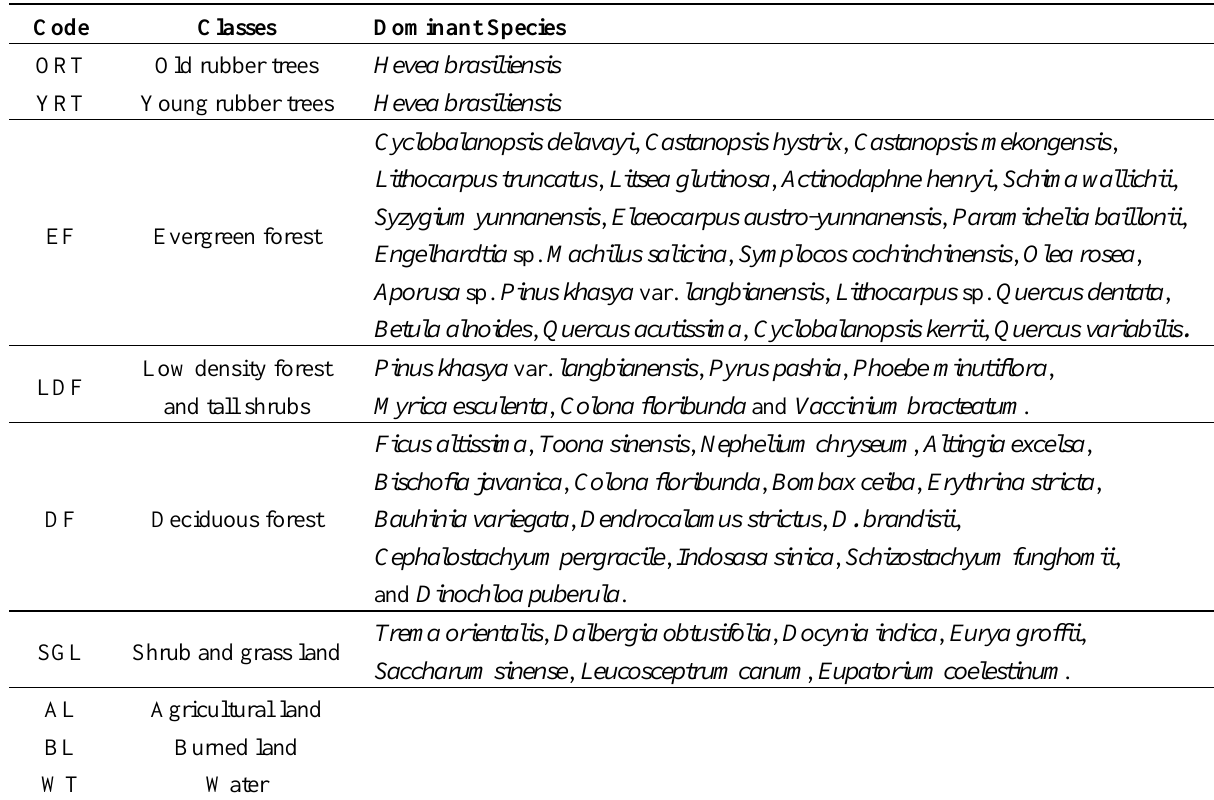
Table 3. The dominant vegetation classes and dominant species in the southern study area.